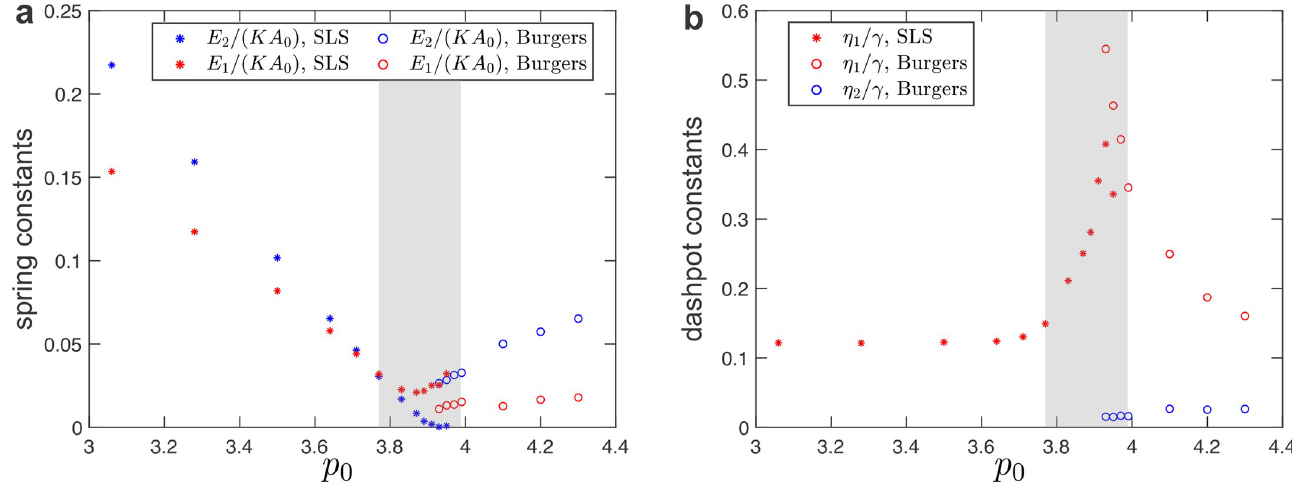
Fig 5. Fitted values of spring-dashpot models for disordered tilings under simple shear. (a) Elastic constants as a function of the target cell-shape parameter, p 0 . (b) Dashpot viscosity constants as a function of the target cell-shape parameter, p 0 . The shaded regions indicate the intermediate regime between the solid and fluid